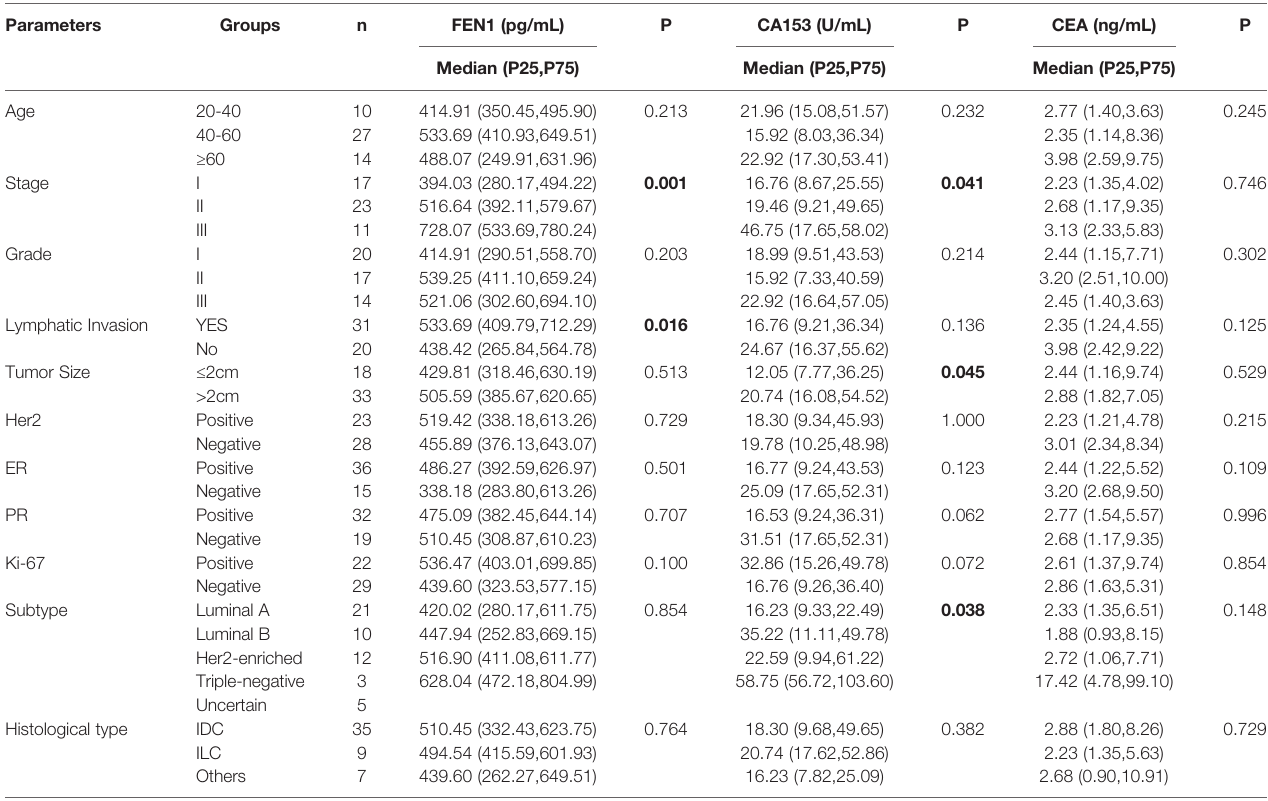
TABLE 3 | The relationship between serum levels of FEN1, CA153, and CEA and BC clinicopathological features. Parameters Groups